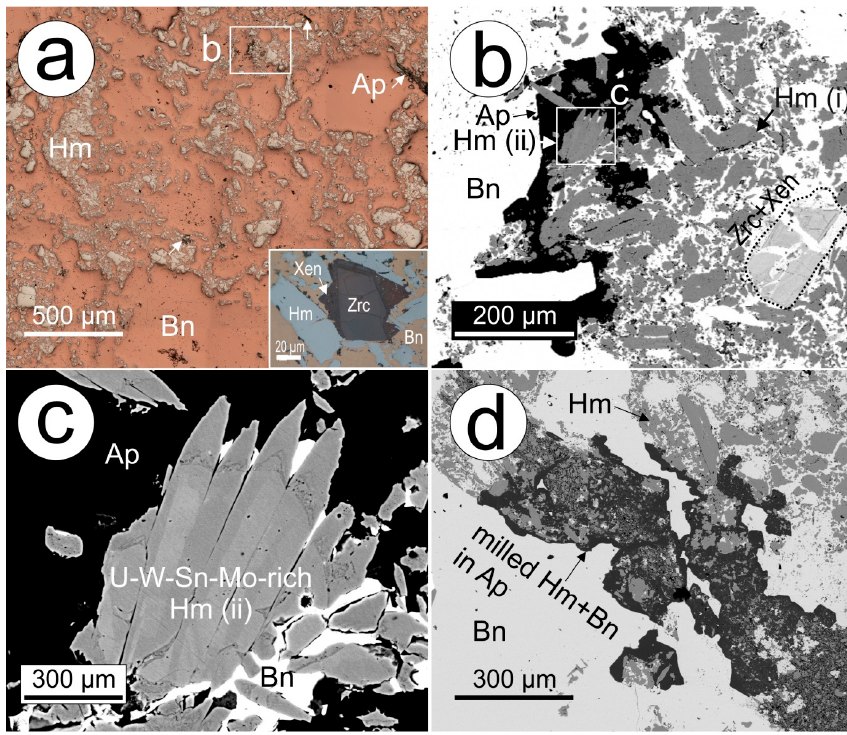
Figure 6. Reflected light microscopy map ( a ) and BSE images ( b , c ) showing aspects of apatite and associated minerals in the high-grade bornite ore. Inset in ( a ) shows zircon surrounded by xenotime. ( b ) Apatite at the boundary between bornite and a hematite-richer domain; most of the coarse hematite is early. Note inclusions of acicular grains/aggregates of oscillatory-zoned hematite (ii) within the apatite and brecciated zircon surrounded by xenotime. ( c ) Detail of zoned hematite within apatite from ( a ). ( d ) Apatite with milled fragments of hematite and bornite. Abbreviations: Ap: apatite; Bn: bornite; Hm: hematite; Xen: xenotime; Zrc: zircon.